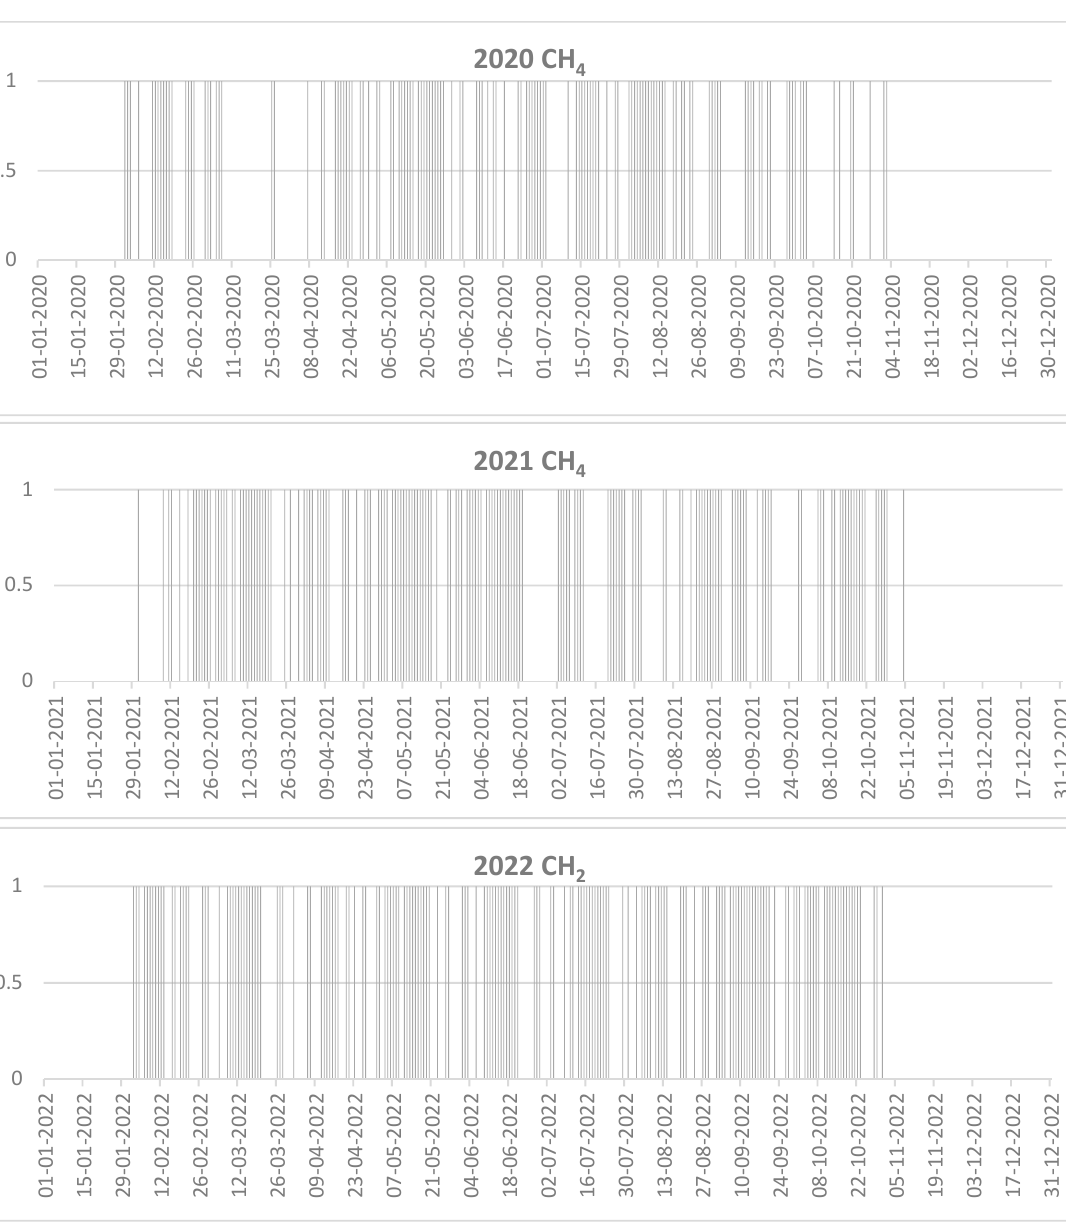
Figure 6. Days with methane emissions of more than 3 σ above the background concentration, Kemerovo region, for each year from 2018 to 2022 separately.